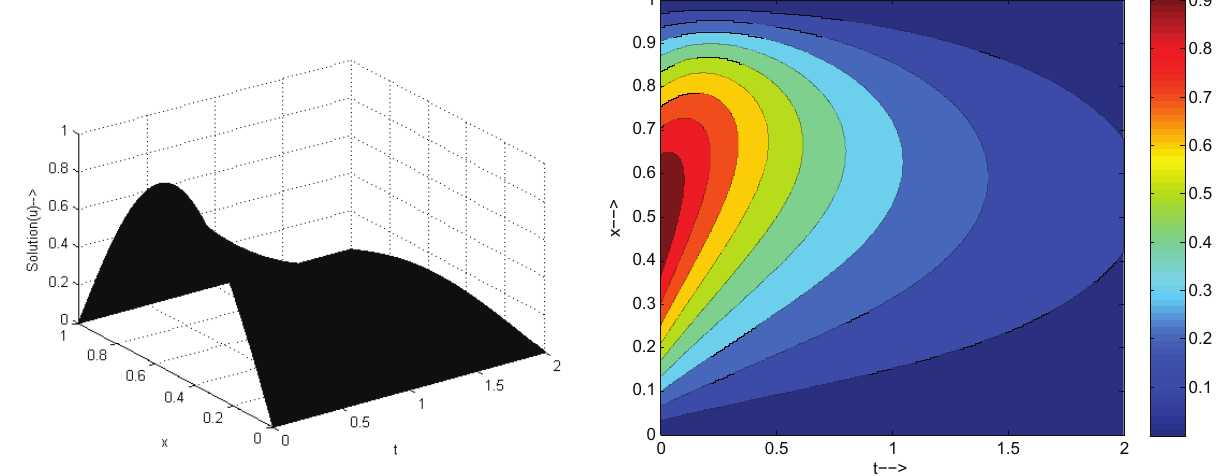
Fig. 2: Physical behavior of numerical solutions of Example 1 at different times in 3D and contour for Δx = 0.0125 , ν = 0.1 at different times with Δt = 0.001